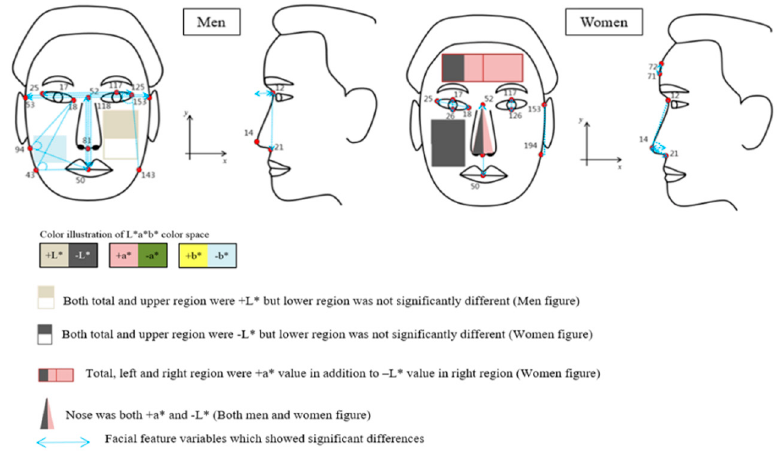
Figure 2. Illustrative figures of facial characteristics for both genders. Table 4. Differences in facial characteristic variables in men.